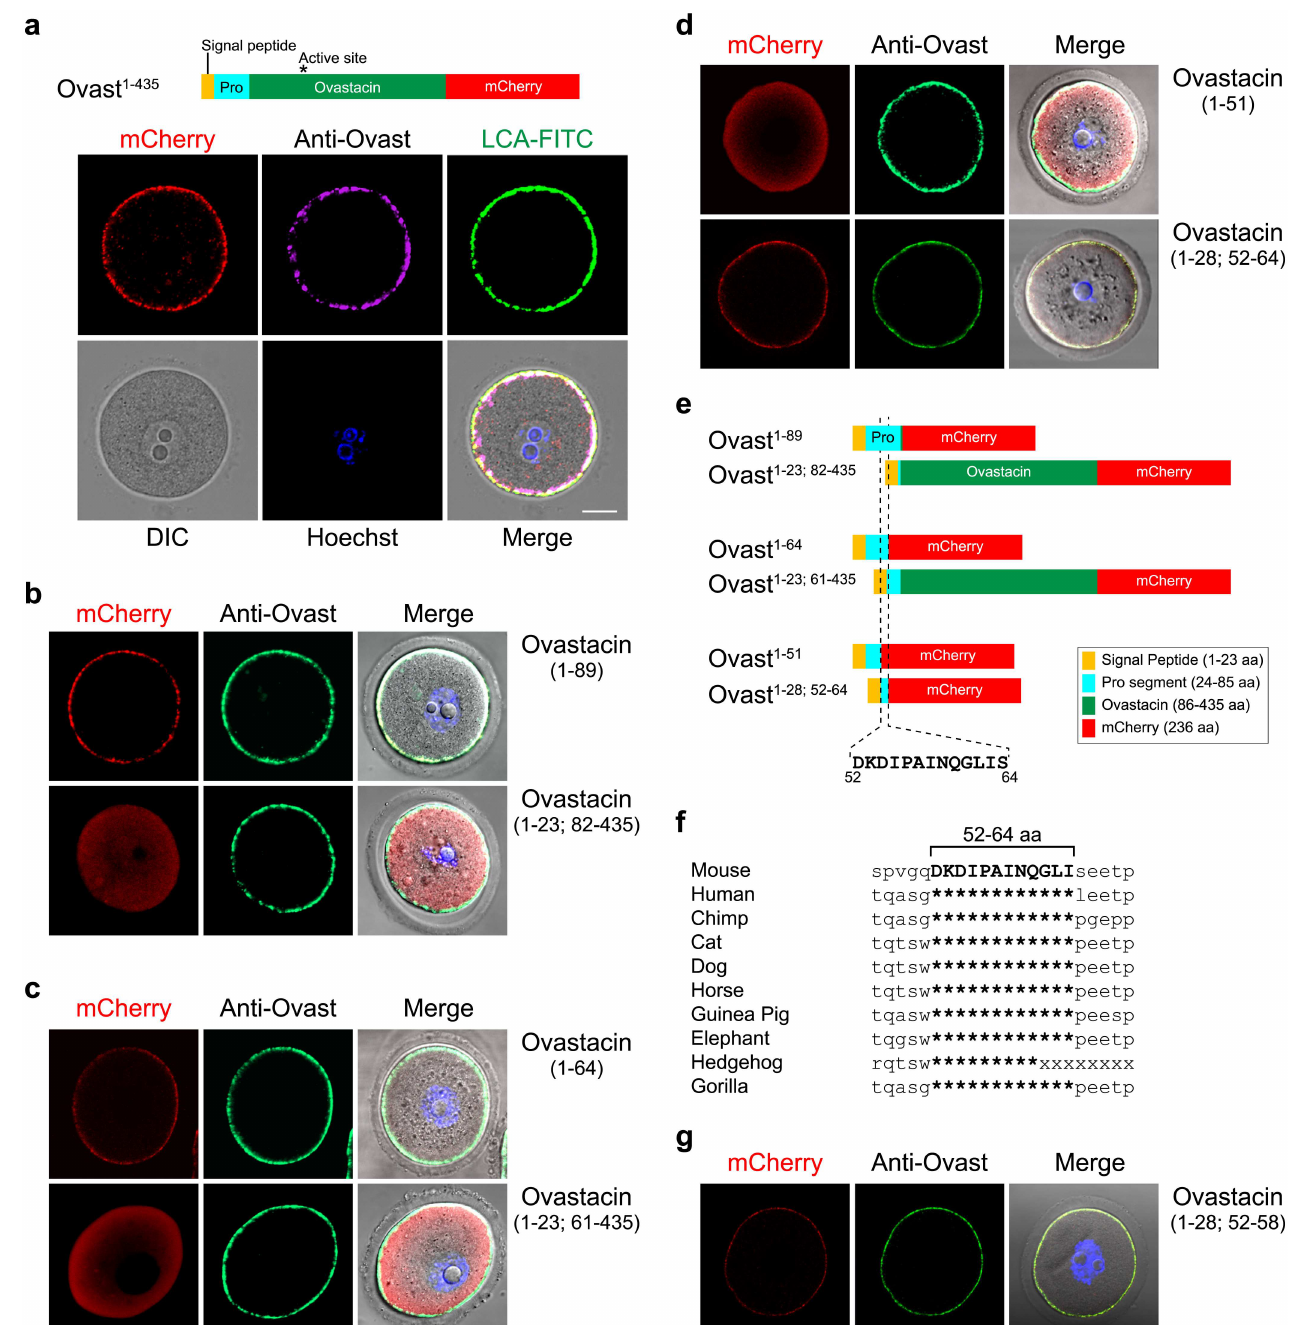
Fig 3. Ovastacin cortical granule localization motif. (a) Growing oocytes (60–65 μ m) were injected with cRNA encodingan ovastacin mCherry fusion protein (top) with a signalpeptide(1–23 aa), a pro segment (24–85aa) and the mature ovastacin enzyme (86–435aa) containing an active site (asterisk, 182 HE LM H VLGFW H 192 ) fused to mCherry (236 aa). Six hr after injection, oocytes were fixed, permeabilizedand stainedwith antibodies to ovastacin,LCA-FITC and Hoechst and imagedby confocaland DIC microscopy (bottom). Scale bar, 20 μ m. (b) Same as (a) after injectionof cRNA encoding either ovastacin 1–89 aa or ovastacin 1–23; 82–435aa indicatedin (e) . (c) Same as (a) after injectionof cRNA encoding either ovastacin 1–64 aa or ovastacin 1–23; 61–435aa indicatedin (e) . (d) Same as (a) after injectionof cRNA encoding either ovastacin 1–51 aa or ovastacin 1–28; 52–64 aa indicatedin (e) . (e) Schematic representation of three pairs of complementary deletion constructs of ovastacin mCherry fusion proteins injectedinto growingoocytes. Dotted lines indicatethe minimalsequence(ovastacin Δ 52–64 ) for localization of the fusion protein to cortical granules. (f) Primary amino acid sequencesof ovastacin from 10 mammals were alignedto mouse ovastacin 47-69 . The conservation of mouse ovastacin Δ 52–64 cortical granulelocalization signal is indicatedby asterisks. (g) Same as (a) after injectionof cRNA encoding ovastacin 1–28; 52–58.